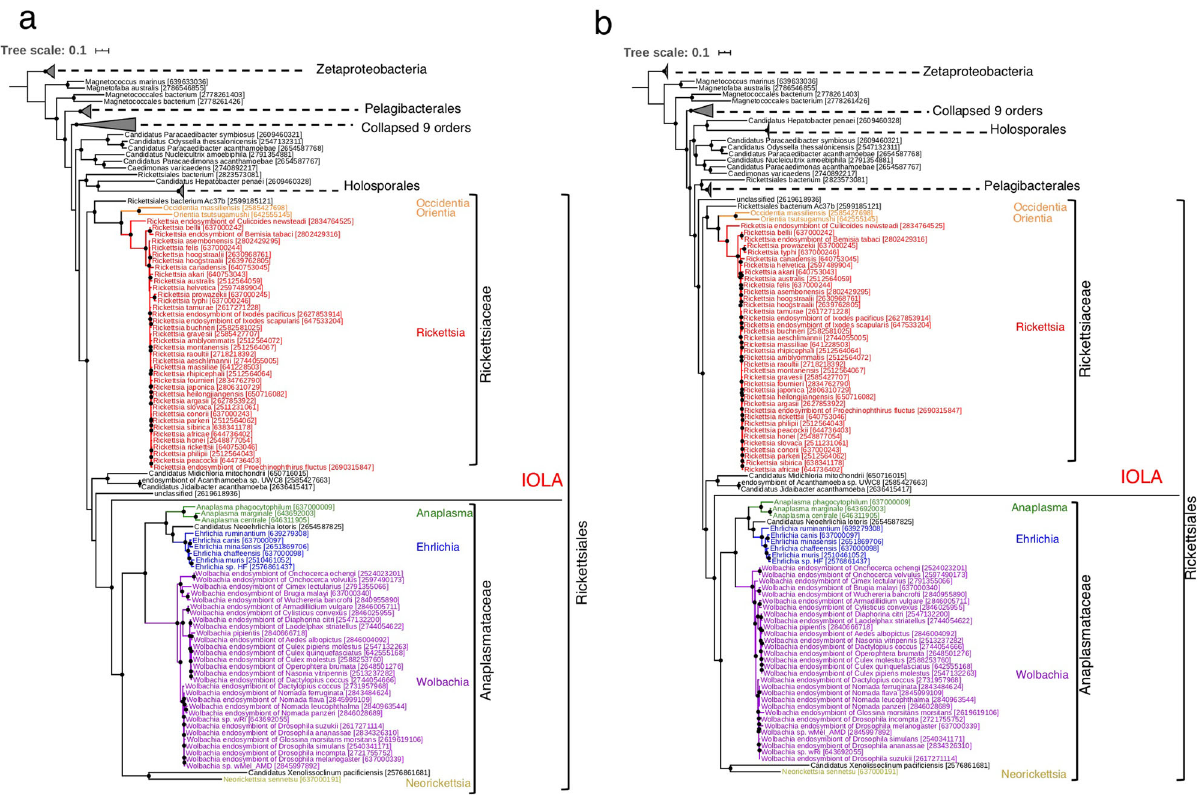
Fig. 4 Maximum likelihood phylogenetic trees based on the concatenated sequences of ribosomal and other housekeeping proteins of class Alphaproteobacteria. a The tree includes 157 species belonging to class Alphaproteobacteria, 7 species of Zeta-proteobacteria (used as outgroups) and IOLA (listed in Supplemental Data 2). A total of 165 sets of the 16 ribosomal proteins were used (the same set as used in Fig. 3). b The 12 housekeeping proteins (SecA, SecY, TsaD, rpoA, RecA, DnaK, GroEL, GyrA, GyrB, PheS, SerS, and LeuS) of the 165 bacterial species analyzed in a were used. Both trees were constructed by the maximum likelihood method with the LG + F + R10 model and 1000 ultrafast bootstrap replicates and either the 1872-position ( a ) or 5048-position ( b ) alignment. Black dots indicate divergence episodes with bootstrap values greater than 80%. The scale bar indicates substitutions per site. In both trees, different genera belonging to order Rickettsiales are presented in different